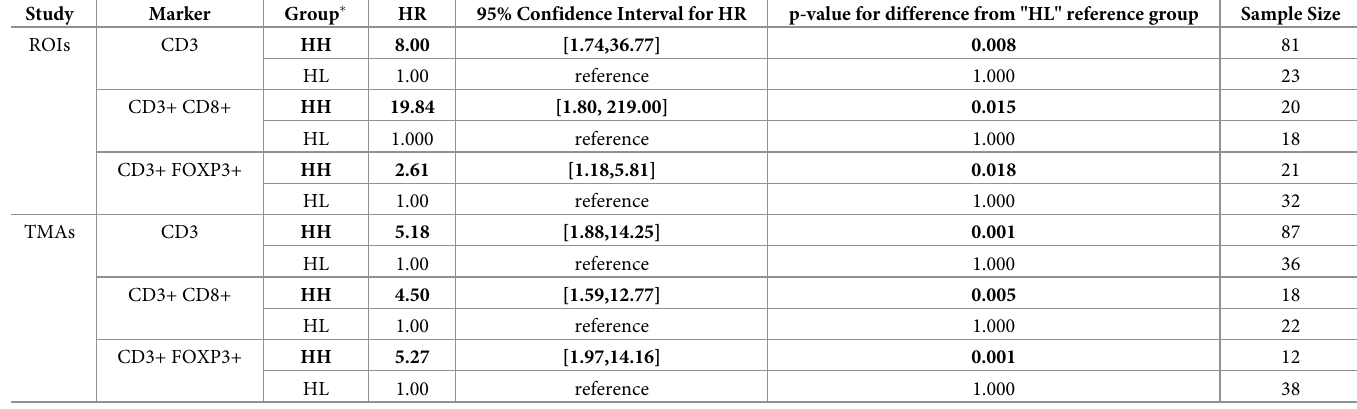
Table 2. Results from survival analysis of the immune marker abundance and spatial clustering from the ROIs and TMAs determined to be high abundance. Mod- els were adjusted for age at diagnosis and stage. Group high abundance/ low spatial clustering (“HL” group) is the reference group. Study Marker